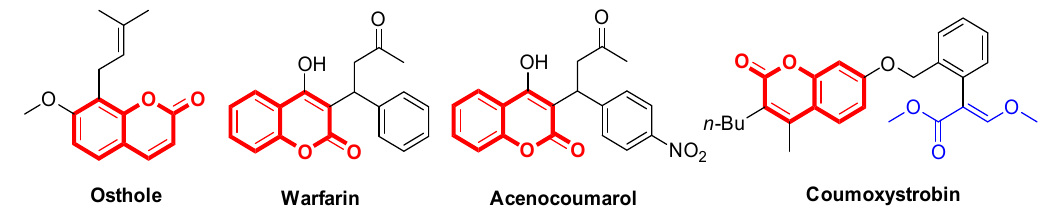
Figure 1. Structures of coumarin-containing drugs and agrochemicals.